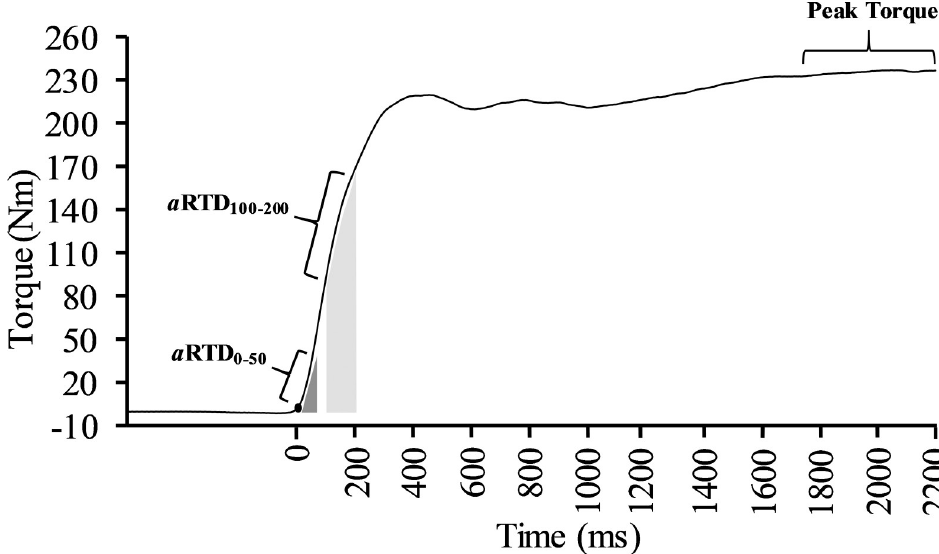
Fig 1. Example of a processed torque signal from a maximal voluntary isometric contraction. Indicated is the portion of the torque-time curve from which rate of torque development from 0 to 50 ( a RTD 0-50 ) and 100 to 200 ms ( a RTD 100-200 ) were calculated as well as impulse from 0 to 50 (dark grey area) and 100 to 200 ms (lighter grey area).